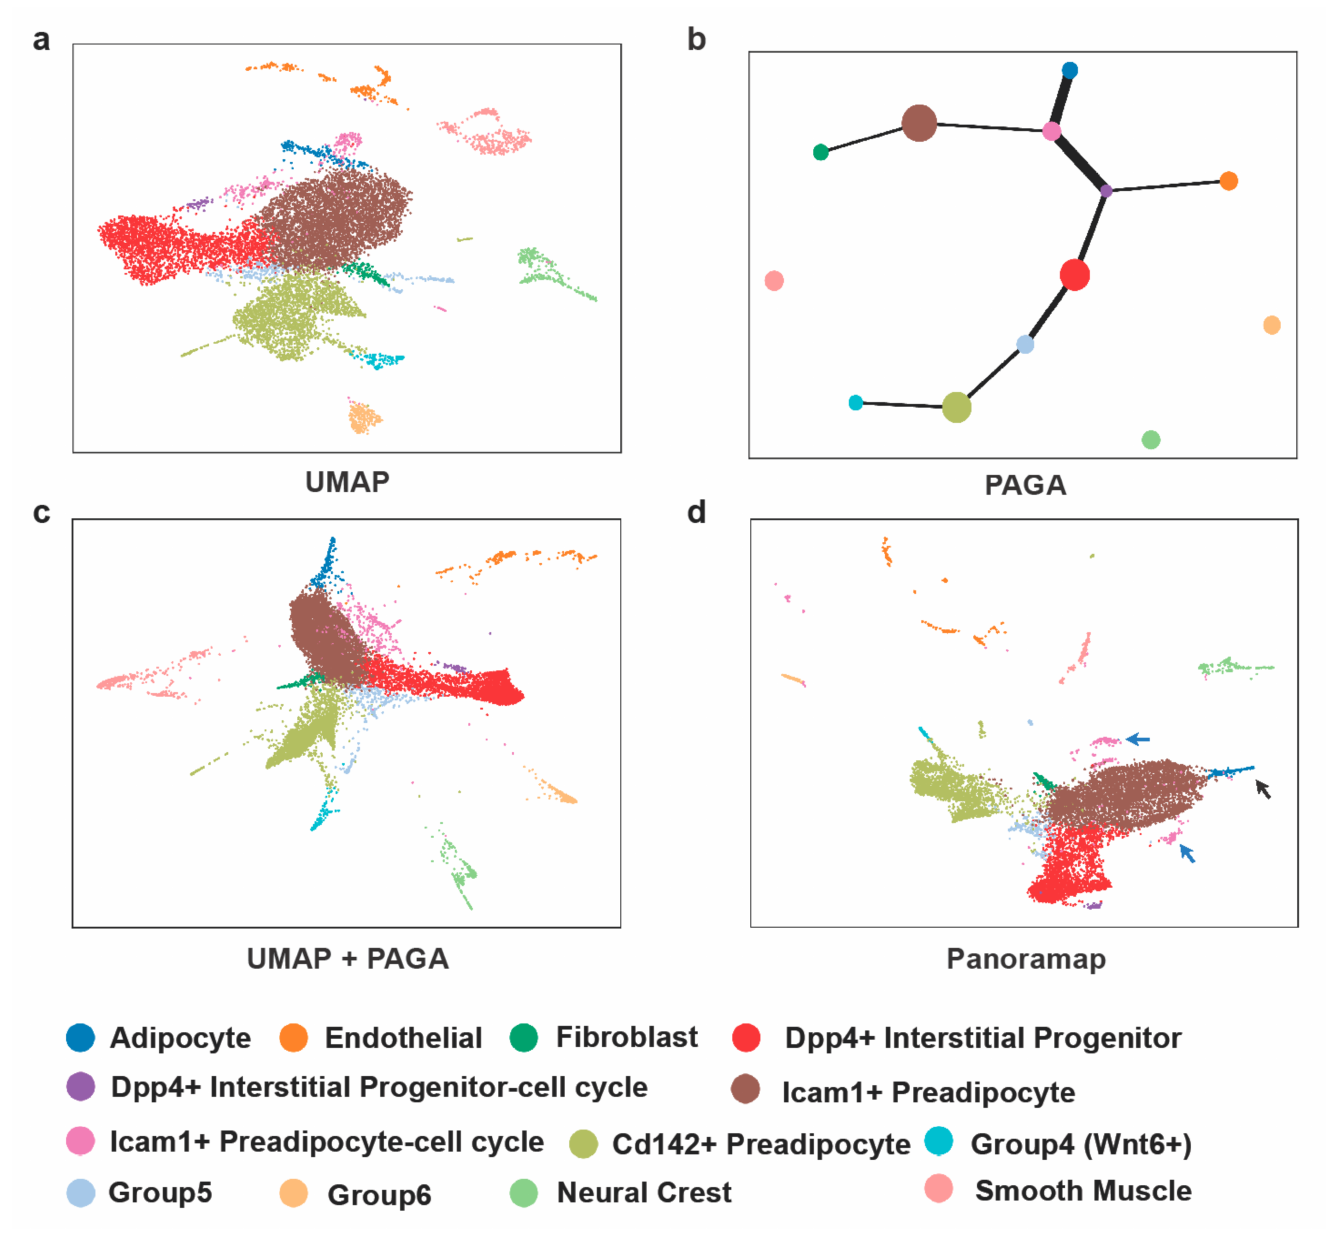
Figure 6. Cell types displayed with Panoramap correlate well with cell development. ( a ) UMAP embedding of cells from murine adipose tissue. ( b ) Trajectory inference using PAGA. ( c ) UMAP with PAGA initialization. ( d ) Panoramap embedding for the murine adipose tissue. The black arrow points to adipocytes and the blue arrow points to the interstitial progenitors with more G2M